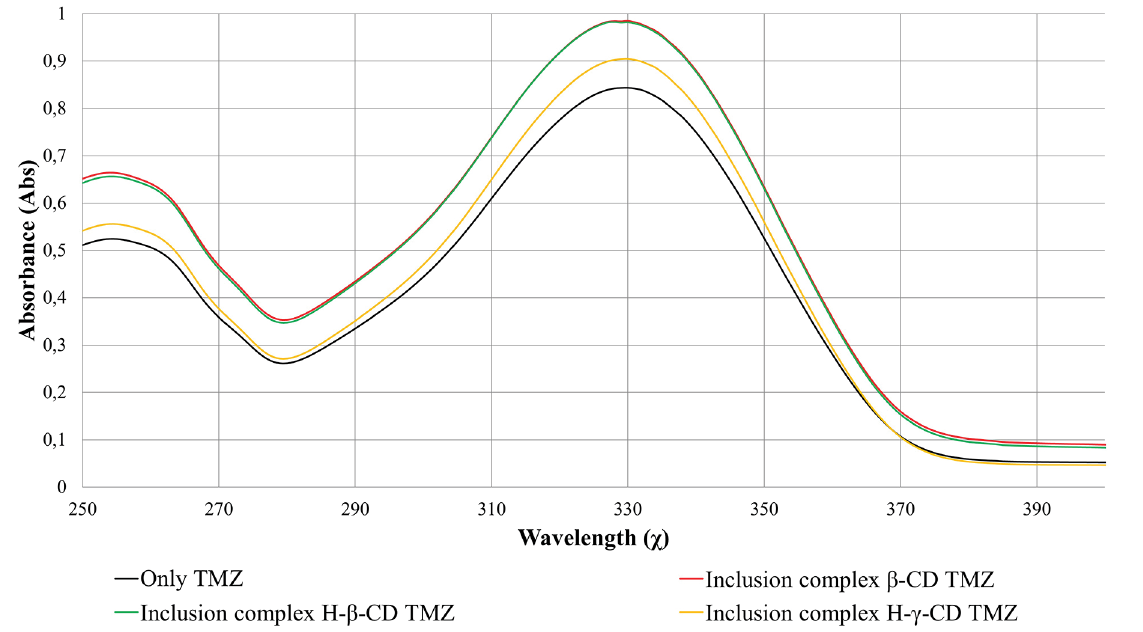
FIGURE 8 - Amount of solubilized TMZ in mg/mL in 0.1 M HCl in the presence of different CDs in 1:1 ratio after the formation of inclusion complex after 24 hours (UV-Vis